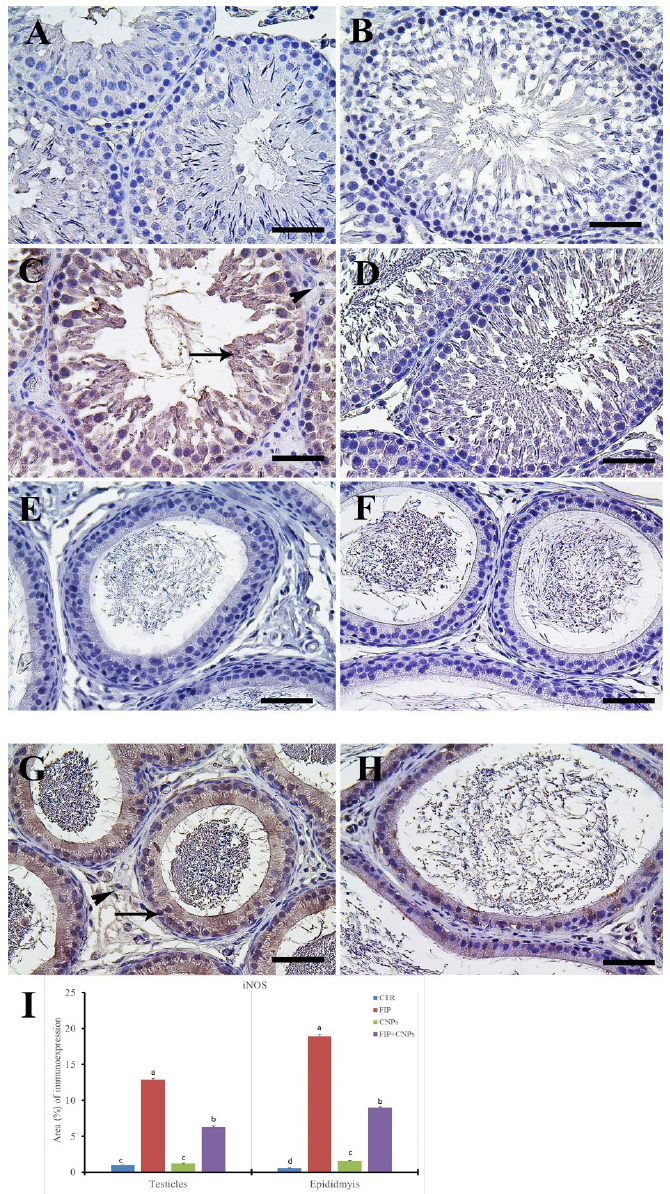
Figure 6. Immunohistochemical staining of rat testis by inducible nitric oxide synthase (iNOS). ( A ) control. ( B ) CeNPs group. ( C ) FIP group showed strong iNOS in the cytoplasm of spermatogenic lineage of the seminiferous tubules (arrow), while the cytoplasm of Leydig’s cells were negatively reacted (arrowhead). ( D ) FIP-supplemented with CeNPs. ( E ) Epididymal control group. ( F ) CeNPs group. ( G ) FIP group showed strong positive iNOS reaction in the epididymal epithelial cytoplasm (arrow) and nearly negative reaction in the interstitial connective tissue (arrowhead). ( H ) FIP-treated with CeNPs. ( I ) Semi-quantification of iNOS in the testicular and epididymal tissues in different groups. Scale bar = 50 µm. Data expressed as mean ± SE, analyzed using one-way ANOVA at p ≤ 0.05.